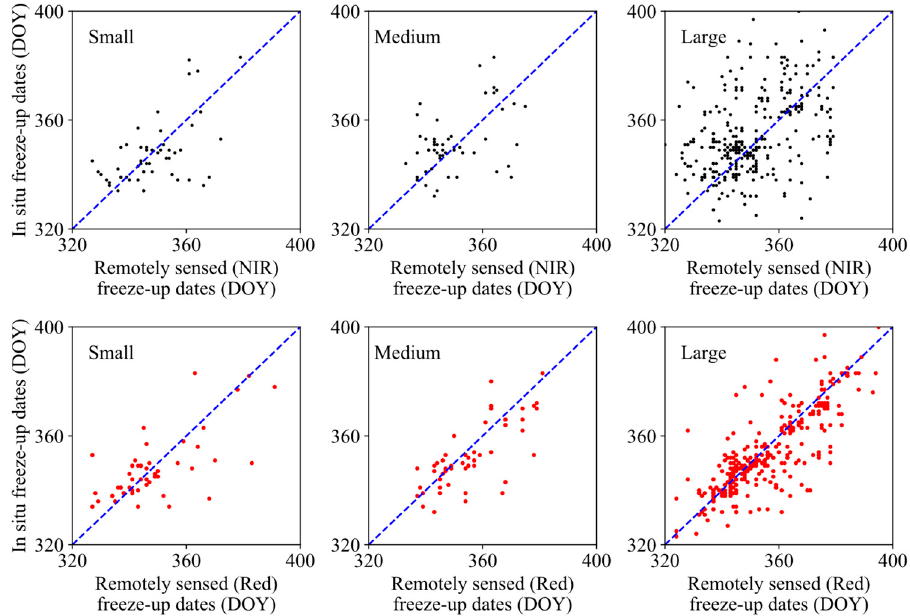
Figure 8. Validation results of freezeup dates. Freezeup dates later than day 365 (or 366 days in a leap year) means freezeup was detected in the following year.